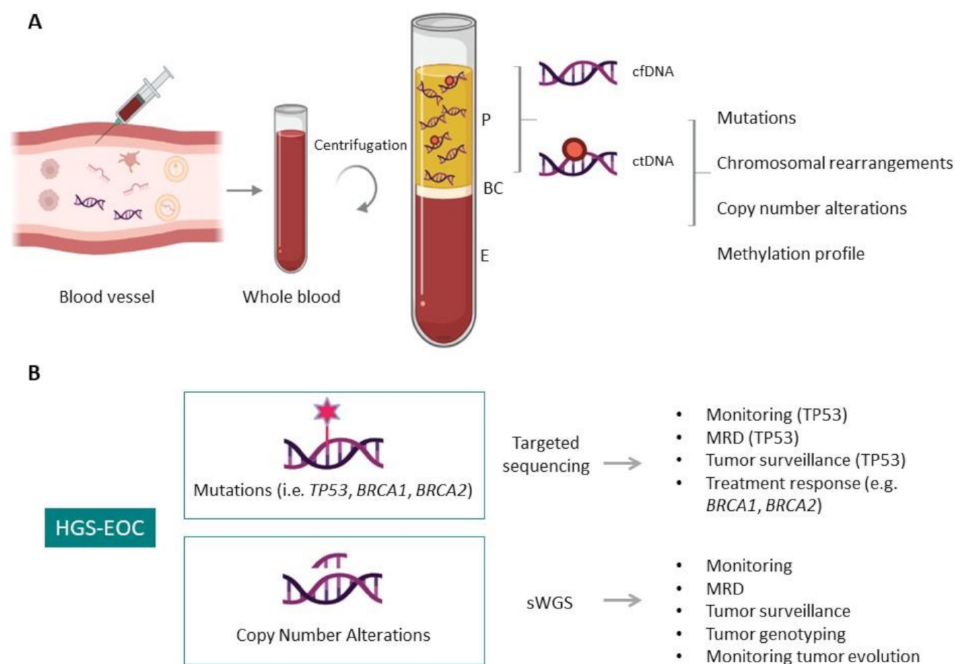
Figure 2. Circulating tumor DNA (ctDNA) in liquid biopsy. ( A ) Schematic representation of ctDNA isolation and genomic characteristic that distinguish ctDNA from cfDNA, providing information of the aberrations that characterize tumor masses. P, plasma; BC, buffy coat; E, erythrocytes. ( B ) Ap- plications of ctDNA analysis in HGS-EOC. The information obtainable by target sequencing and shallow whole-genome sequencing (sWGS) are illustrated. MDR, minimal residual